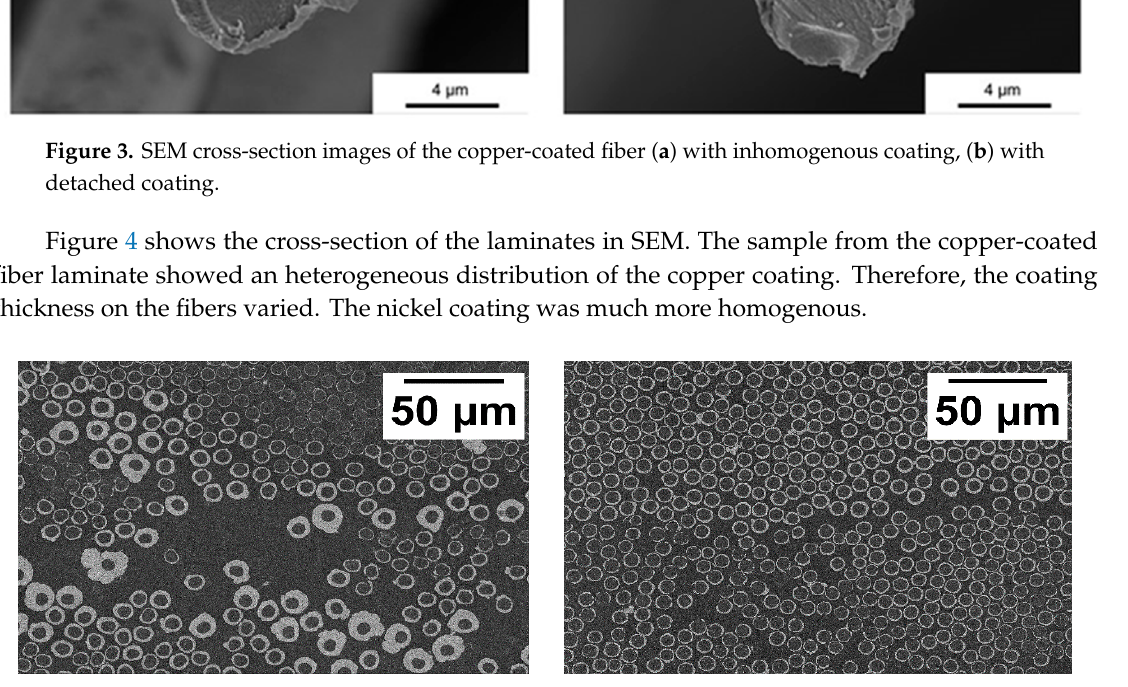
Figure 4. SEM cross-section images of the laminates from ( left ) the copper-coated fiber (39.5 vol % fiber) and ( right ) nickel-coated fiber (49.4 vol % fiber).